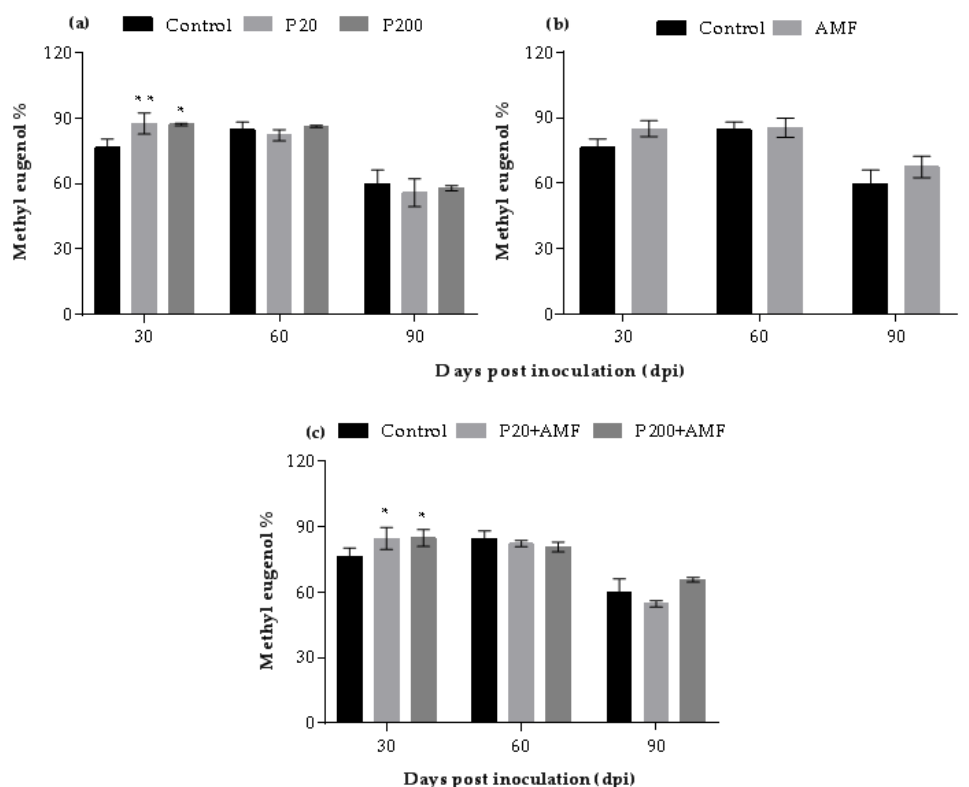
Figure 2. Methyl eugenol variation in Piper divaricatum : ( a ) plants treated with 20 and 200 mg of P · dm − 3 of soil (P20 and P200); ( b ) plants inoculated with AMFs (AMF); ( c ) plants inoculated with AMFs and treated with 20 and 200 mg of P · dm − 3 of soil (P20 + AMF and P200 + AMF). Statistical difference according to Bonferroni test ( p < 0.05). ** significant ( p < 0.01), * low significance ( p < 0.1).